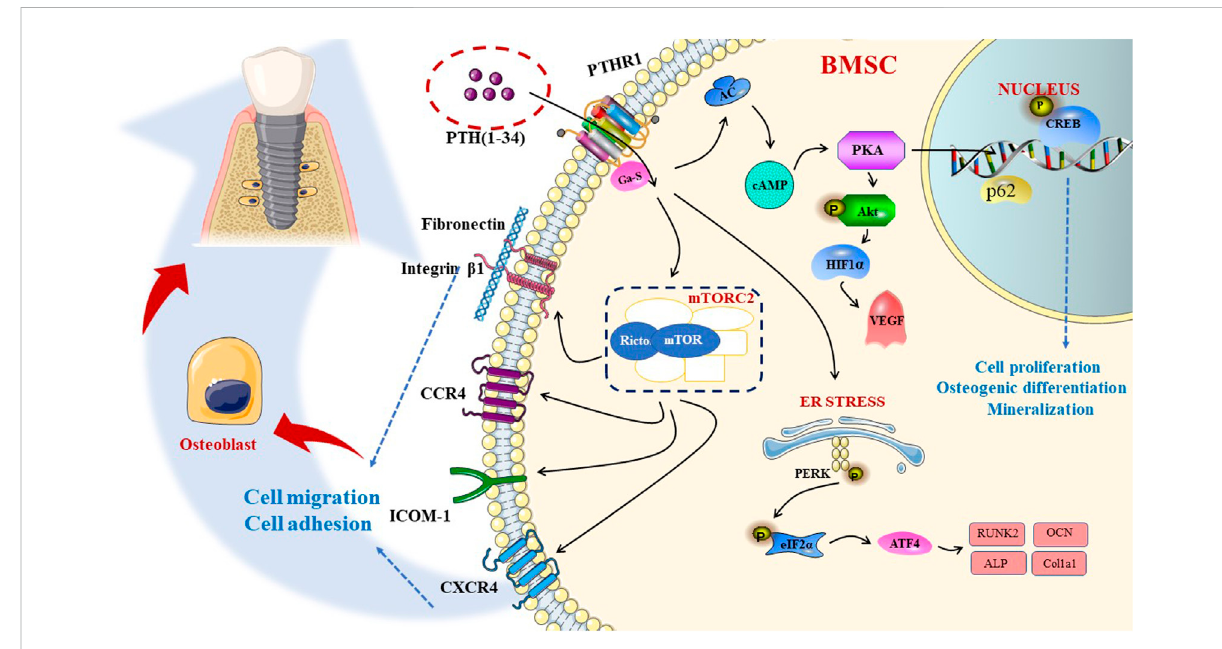
FIGURE 3 PTH affects the proliferation, differentiation, and migration of osteoblasts, respectively, through different pathways, including cAMP-PKA, mTORC2 pathways and so on, along with the ER stress to promote